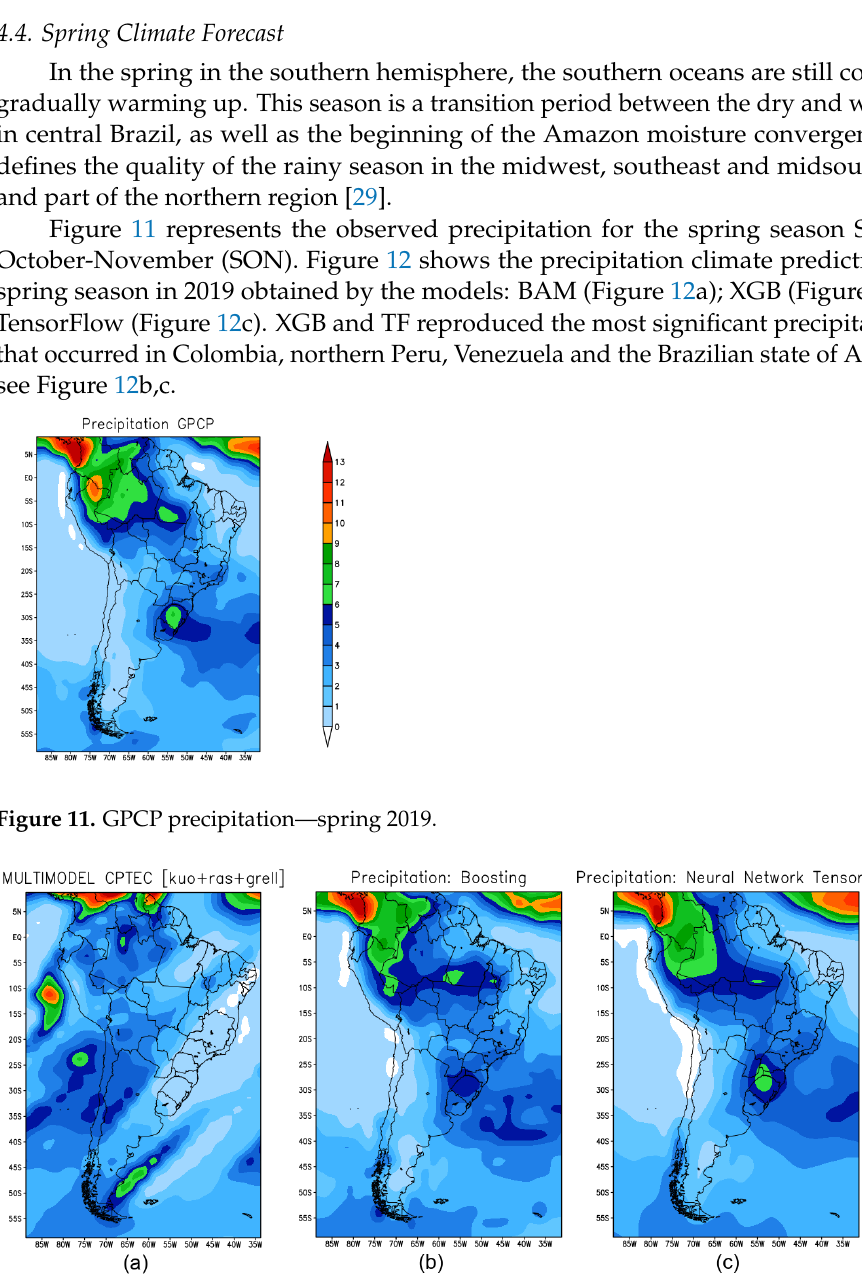
Figure 12. Seasonal climate forecast for spring in South America: ( a ) precipitation predicted by BAM model; ( b ) prediction obtained by XGBoost model; ( c ) prediction obtained by